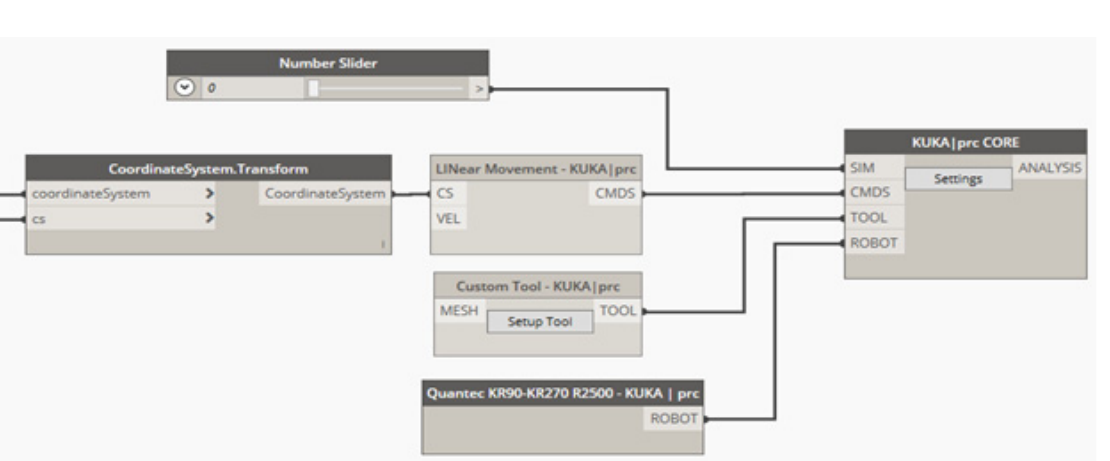
Figure A9. Transfer of points cloud to the printing robot work plane.